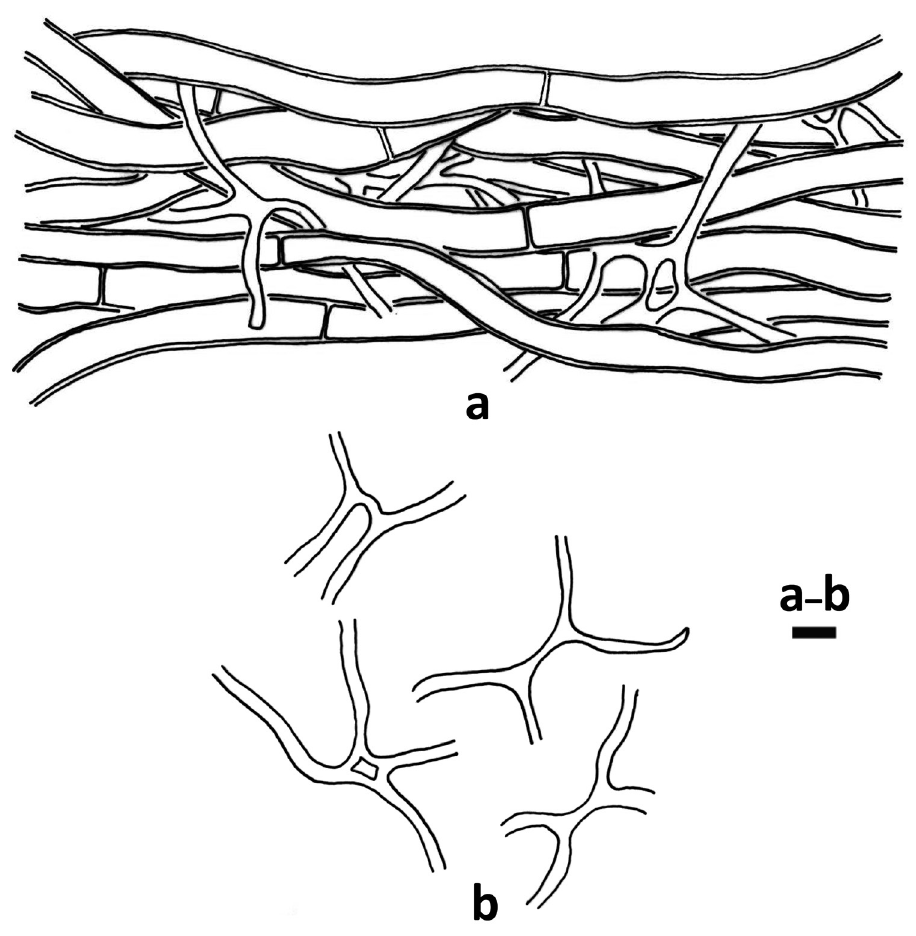
Figure 4. Hydnophanerochaete odontoidea (holotype of Phanerochaete subodontoidea , CWN 00776 ) a Part of the vertical section of subiculum near substratum b Quasi-binding hyphae. Scale bar: 5 μm ( a–b )